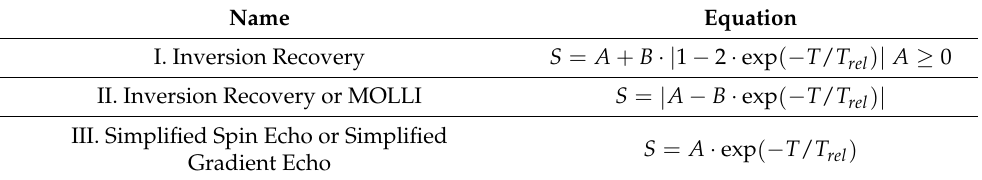
Table 1. Some MRI signal models can be fitted using the algorithm described in this manuscript. The fit can be partially linearized in all cases, so only one parameter (relaxation time) needs to be varied to find the lowest